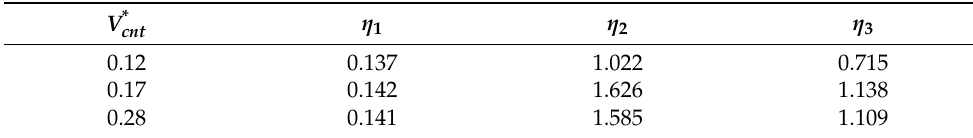
T = cnt (PMMA/CNT at